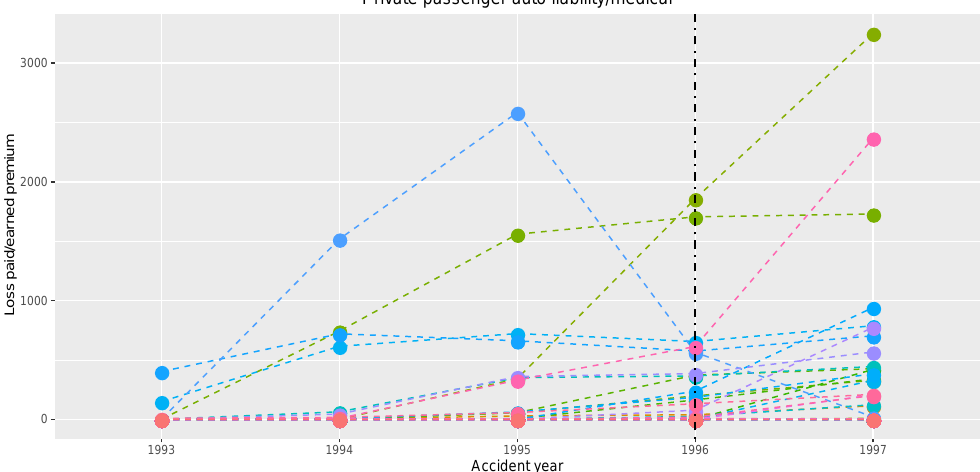
Figure 7. Development of the yearly total claim amounts normalized by the earned premium together for the second half of the original observation period with the estimated change point (cid:98) τ 146 = 4 (corresponding to year